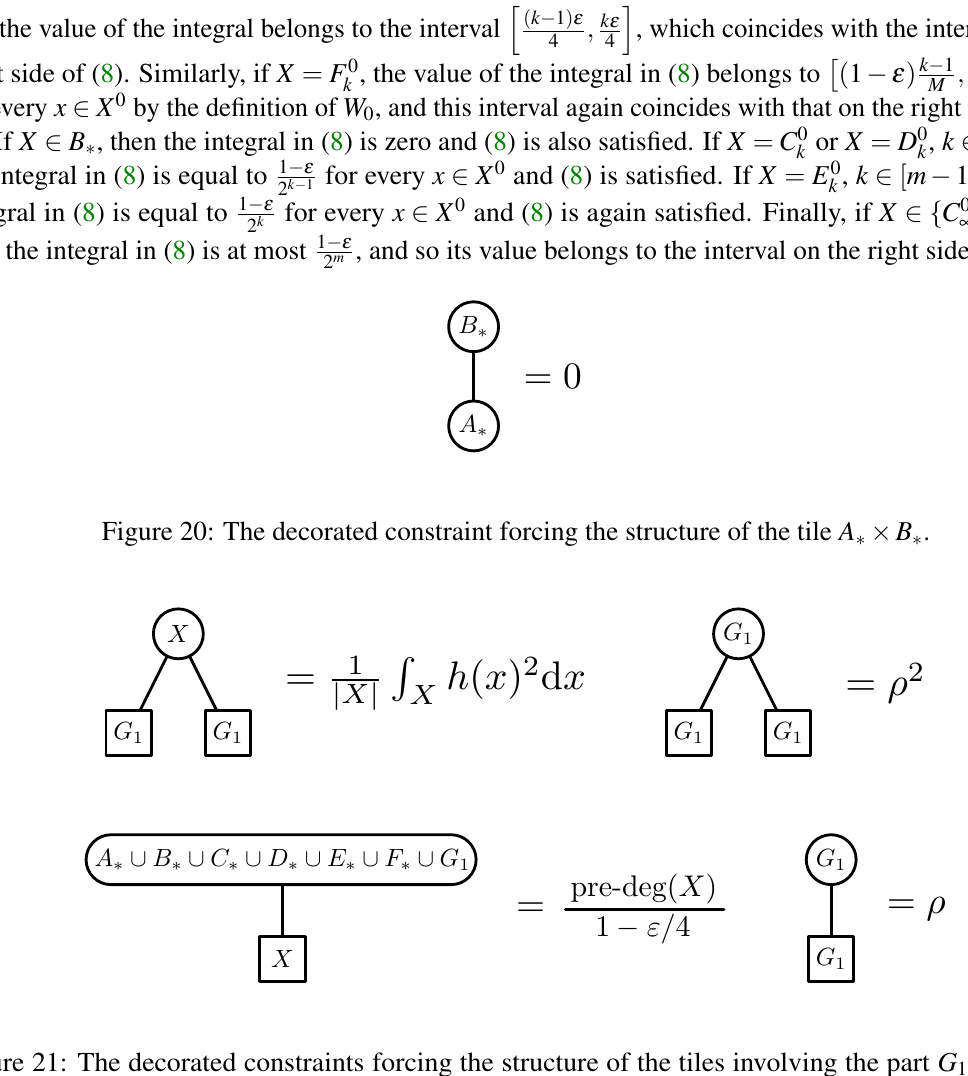
Figure 21: The decorated constraints forcing the structure of the tiles involving the part G 1 . The first constraint should hold for every X ∈ P \ { G 1 , G 2 } and the last constraint for every X ∈ P \ { G 2 }